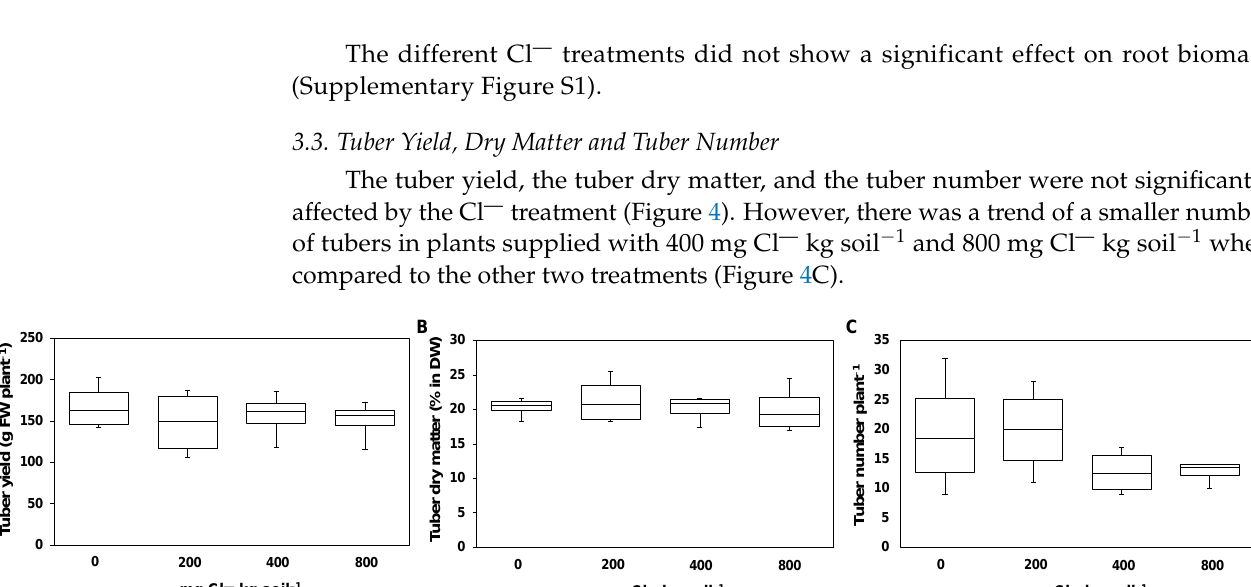
Figure 4. The effect of increasing chloride (Cl — )-fertilization on tuber yield, tuber dry matter and tuber number. Tuber yield ( A ), tuber dry matter ( B ), and tuber number at harvest ( C ) (87 days after planting). Plants were treated with four Cl — supplies: 0 mg Cl — kg soil − 1 (control plants); 200 mg Cl — kg soil − 1 ; 400 mg Cl — kg soil − 1 ; 800 mg Cl — kg soil − 1 . Mean ± SE values; n = 4. No indication means there was no significant effect.